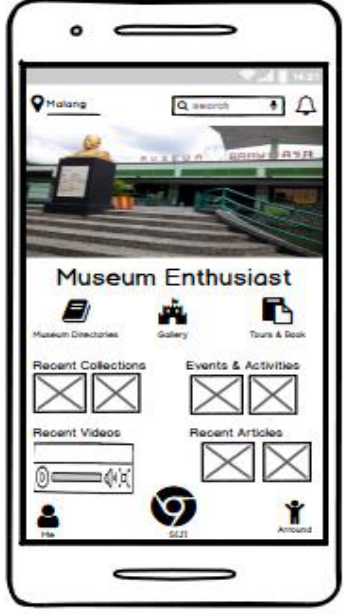
Fig. 5 Application Interface